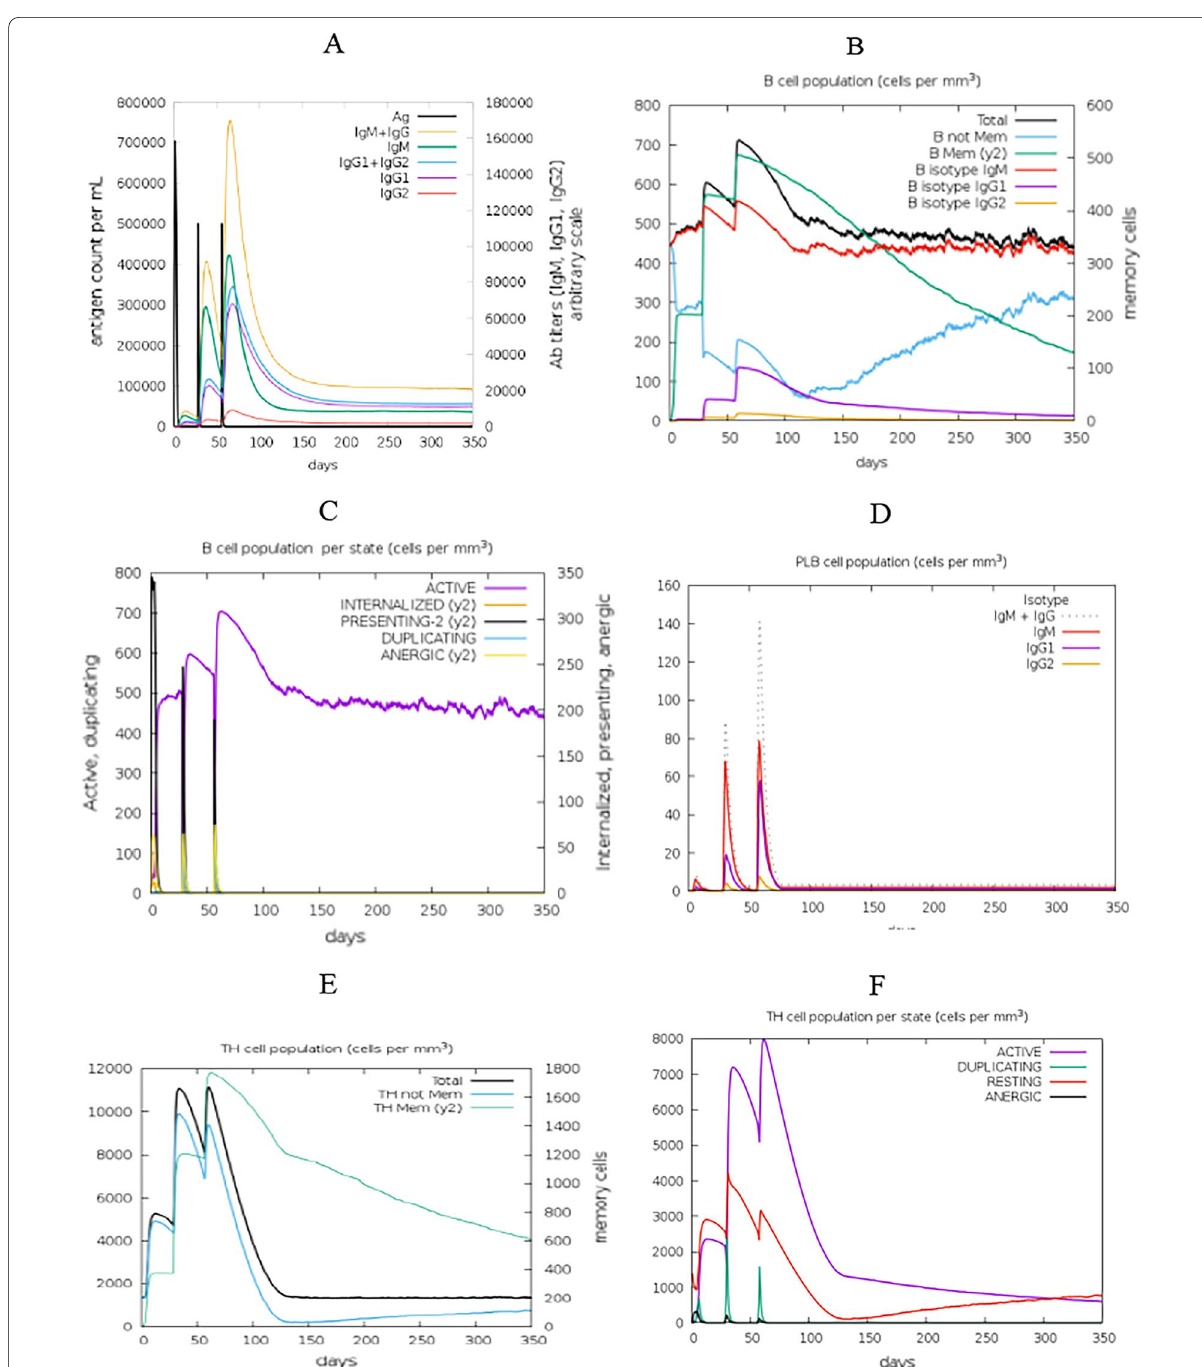
Fig. 9 The immune simulation results of the vaccine construct. A Immunoglobulins levels with respect to antigen concentration, B B cell population, C B cell population per state, D plasma B cell population, E helper T cell population, F helper T cell population per state, G cytotoxic T cell population, H cytotoxic T cell population per state, I macrophage population per state, J dendritic cell population per state and K production of cytokine and interleukins with Simpson